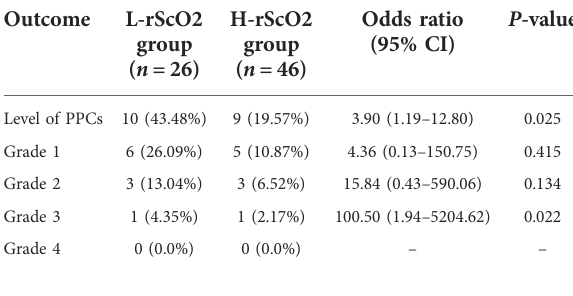
TABLE 2 Comparisons of PPCs between the H-rScO2 and L-rScO2 groups after propensity score matching.